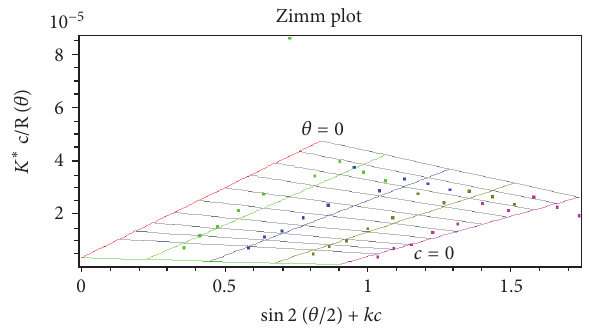
F 5: Zimm plot of KGM in water solution by